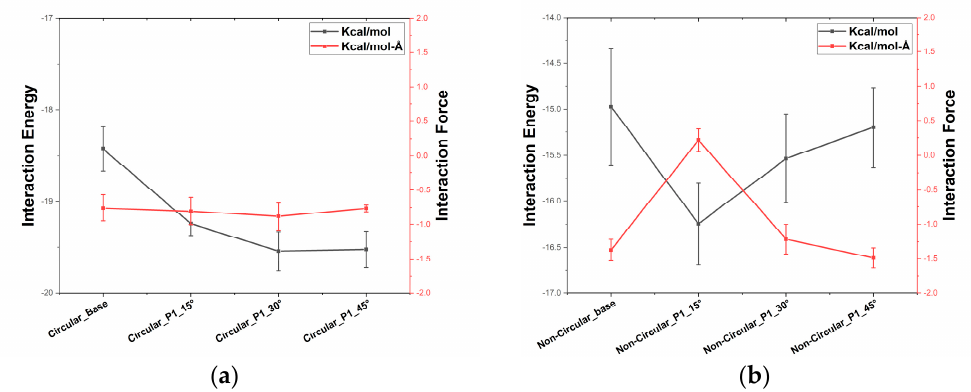
Figure 6. Interaction energy between the carbon atoms of the pore with the oxygen atoms of water molecules and the interaction force along Z − direction for the pattern 1 ( a ) circular porous membrane ( b ) non-circular porous membrane.